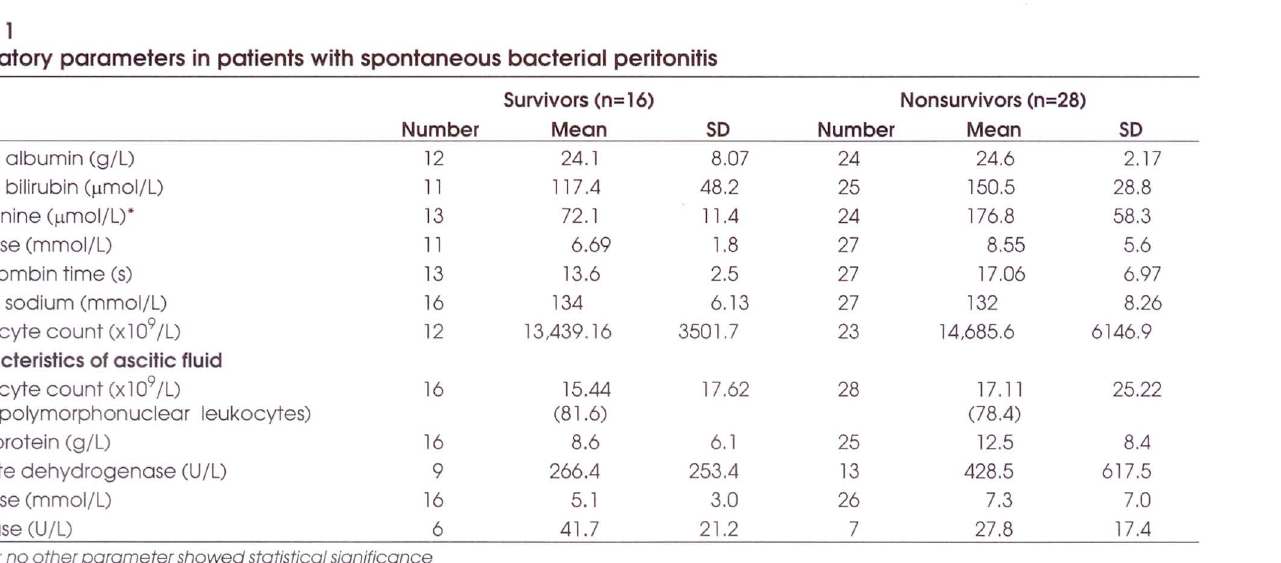
Laboratory parameters in patients with spontaneous bacterial